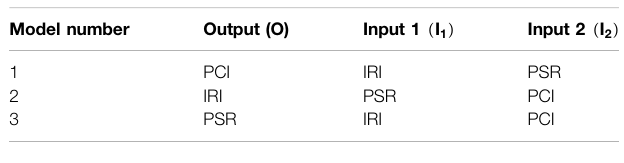
TABLE 3 | Output and input for developed ANN